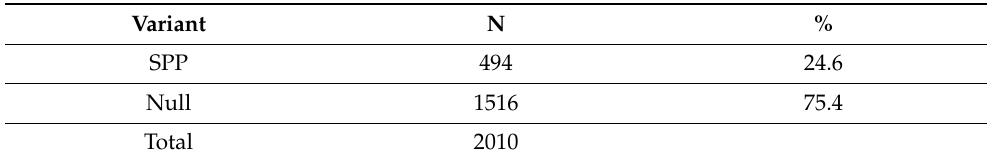
Table 3. Distribution of overt SPPs and null subjects in the Spanish of Tucson 19th and 20th century newspapers.